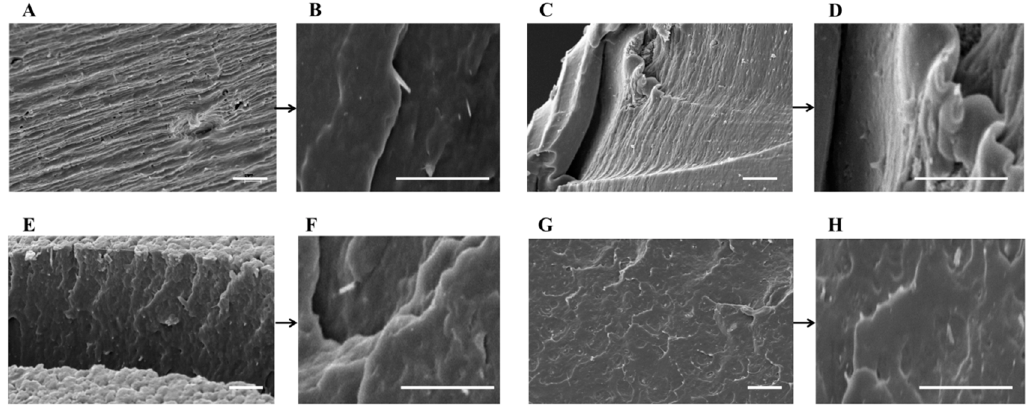
Figure 3. SEM images of ( A , B ) PA6 melt _HNT H _4; ( C , D ) PA6 melt _HNT S _4; ( E , F ) PA6 melt _HNT H _4_APTES; and ( G , H ) PA6 melt _HNT S _4_APTES (scale bar: 2 µm).